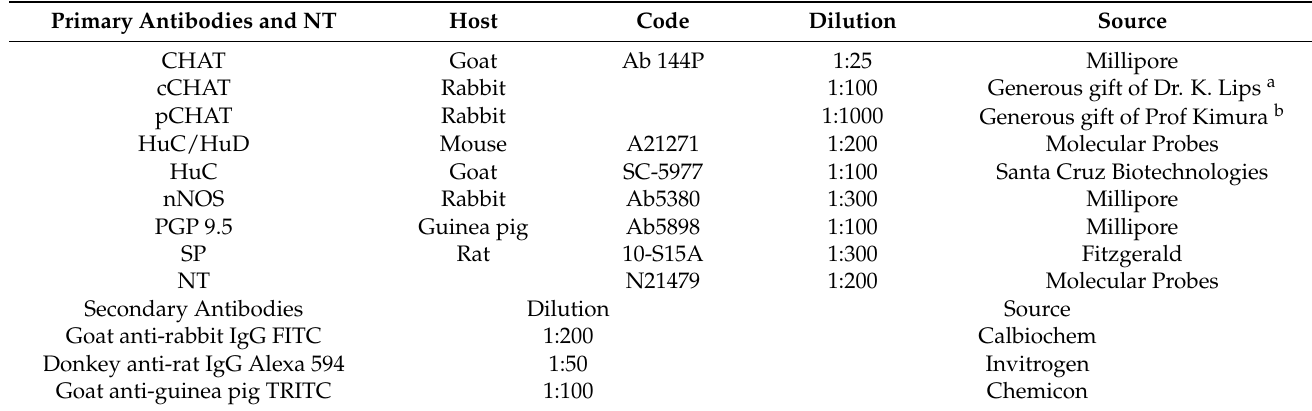
Table 1. Details of antibodies and NeuroTrace ®